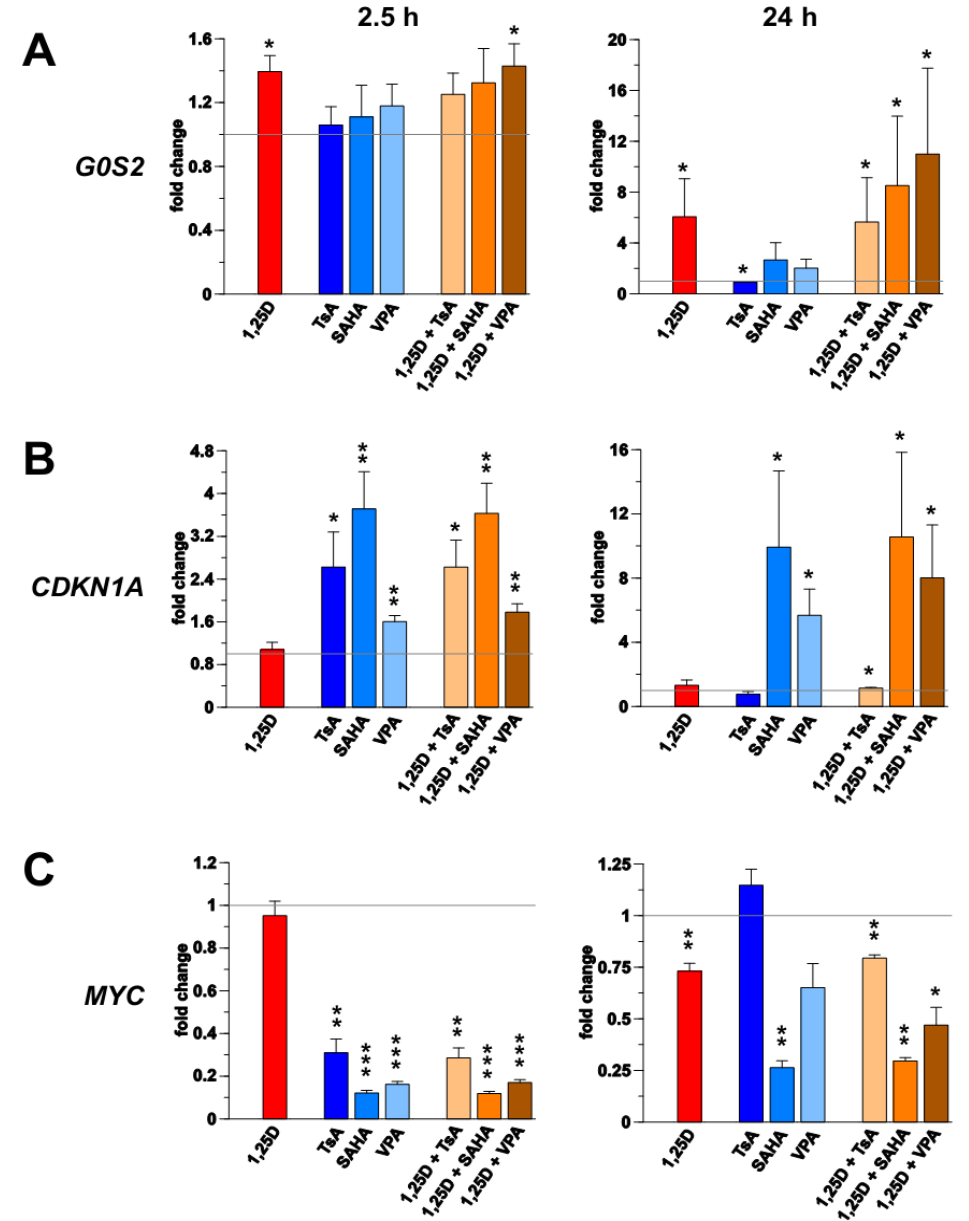
Figure S2. Short- and long-term effects of HDAC inhibition on G0S2 , CDKN1A and MYC expression. qPCR was performed to determine the relative changes of mRNA expression of the genes G0S2 , CDKN1A and MYC normalized by the three reference genes B2M , GAPDH and HPRT1 in undifferentiated THP-1 cells in response to incubation with 1,25(OH) D (1,25D), TsA, SAHA and VPA, alone or in combination, for 2.5 and 24 h. 2 3 The columns represent the means of three independent experiments and the bars indicate standard deviations. Two-tailed Student’s t-tests were performed to determine the significance of the mRNA expression changes by the stimuli (* p < 0.05; ** p < 0.01; *** p <